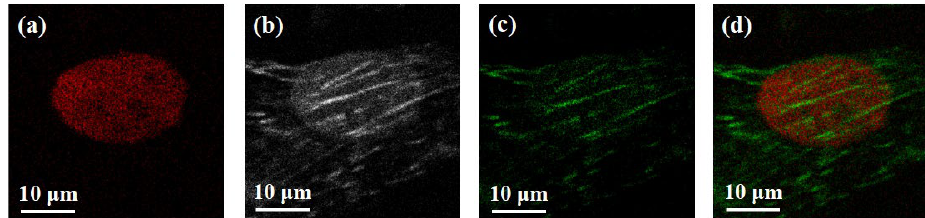
probe, the fluxes in filter C and filter STAR GREEN